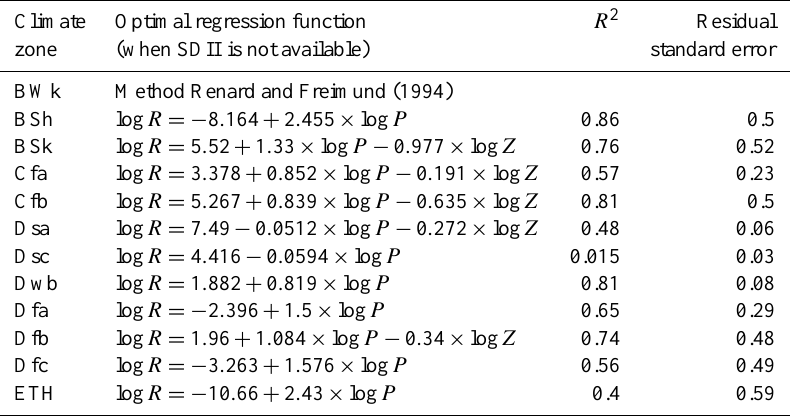
Table 5. Linear multiple regression equations for different climate zones for regions that have no data on the simple precipitation intensity index, SDII (mmday − 1 ). The regression equations relate high resolution erosivity from the USA to the annual total mean precipitation, P (mm), and/or the mean elevation, z (m).